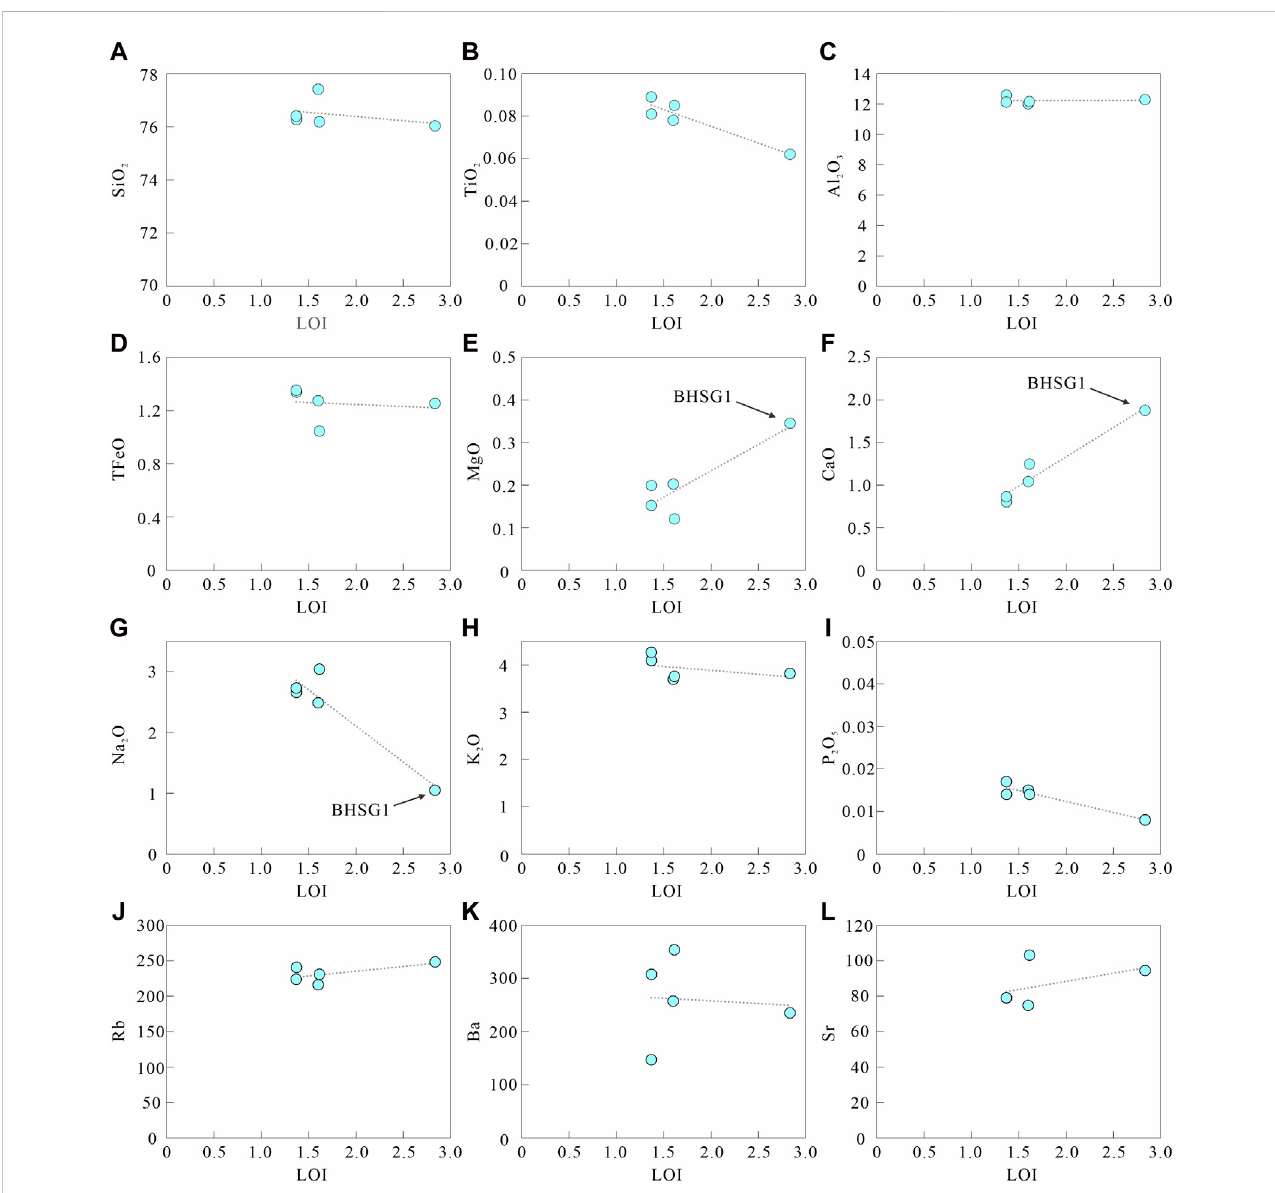
FIGURE 8 LOI versus major elements, Rb, Ba, and Sr plots. The label BHSG1 refers to sample BHSG1 in Table